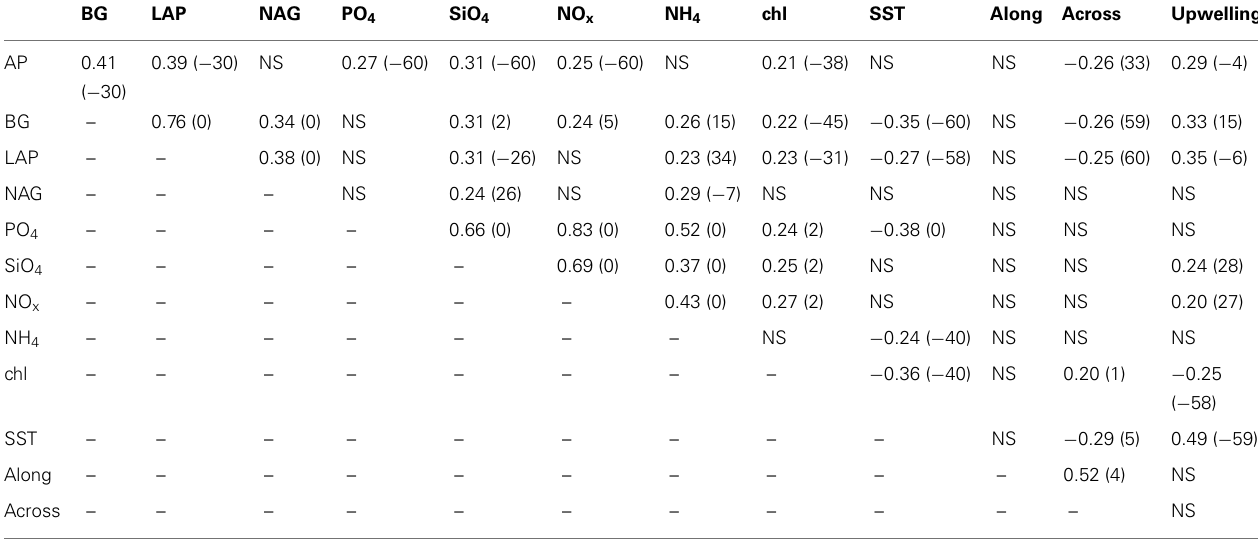
Table 3 | Significant ( P < 0.05) cross-correlation coefficients and lags for bulk seawater enzyme activities, nutrient concentrations, MODIS chlorophyll (chl), and sea surface temperatures (SST), alongshore or across-shore ocean currents, and the Bakun upwelling